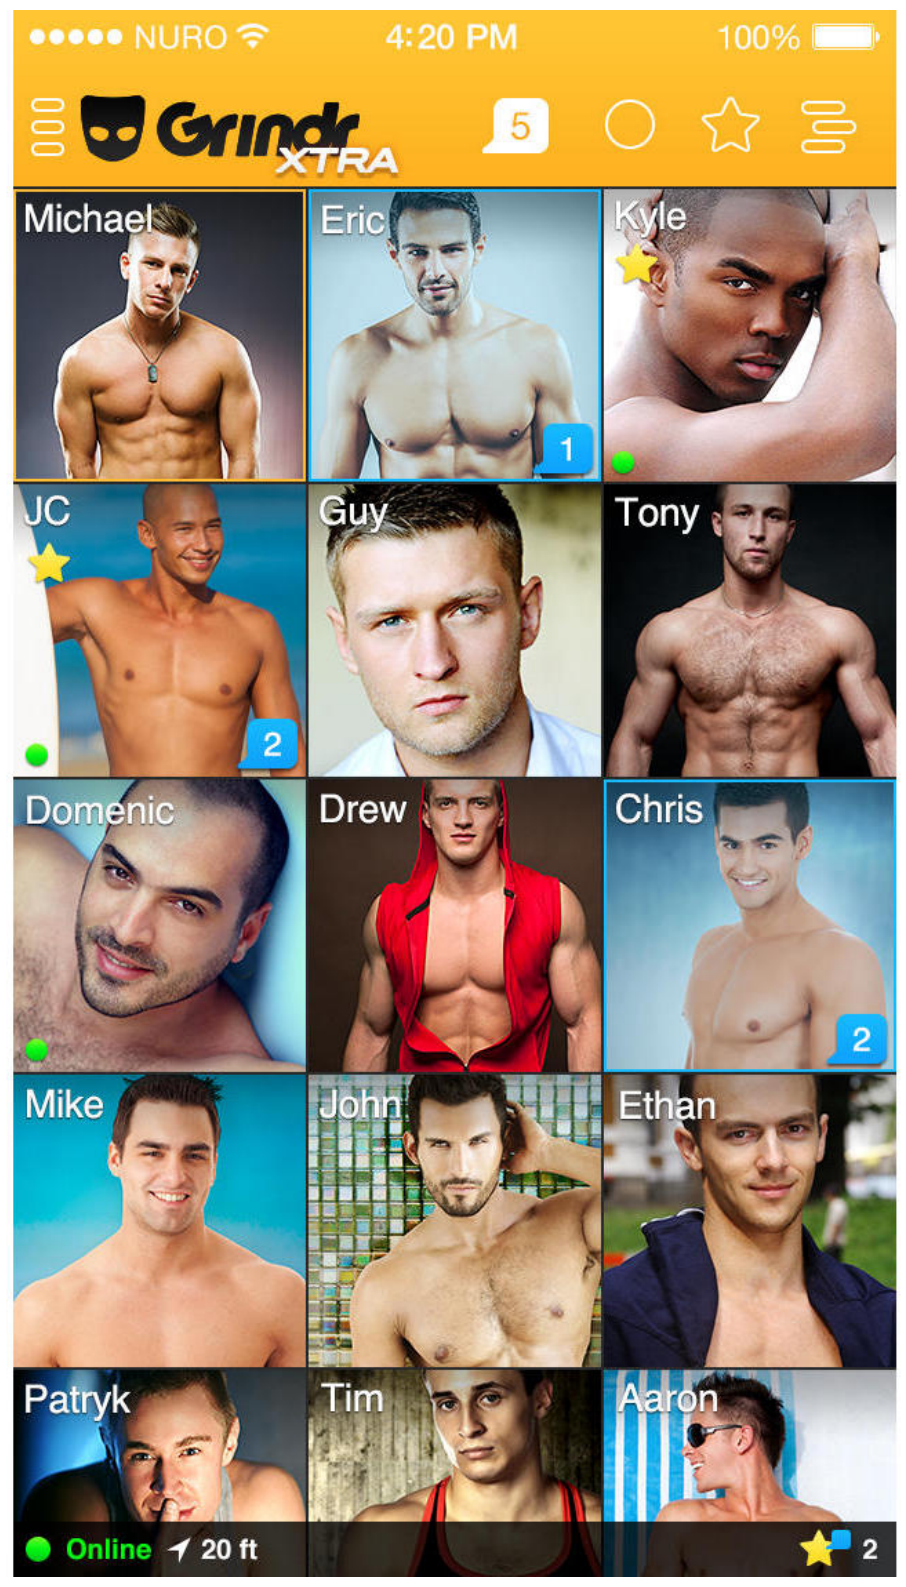
Figure 1. Screenshot of the Grindr user